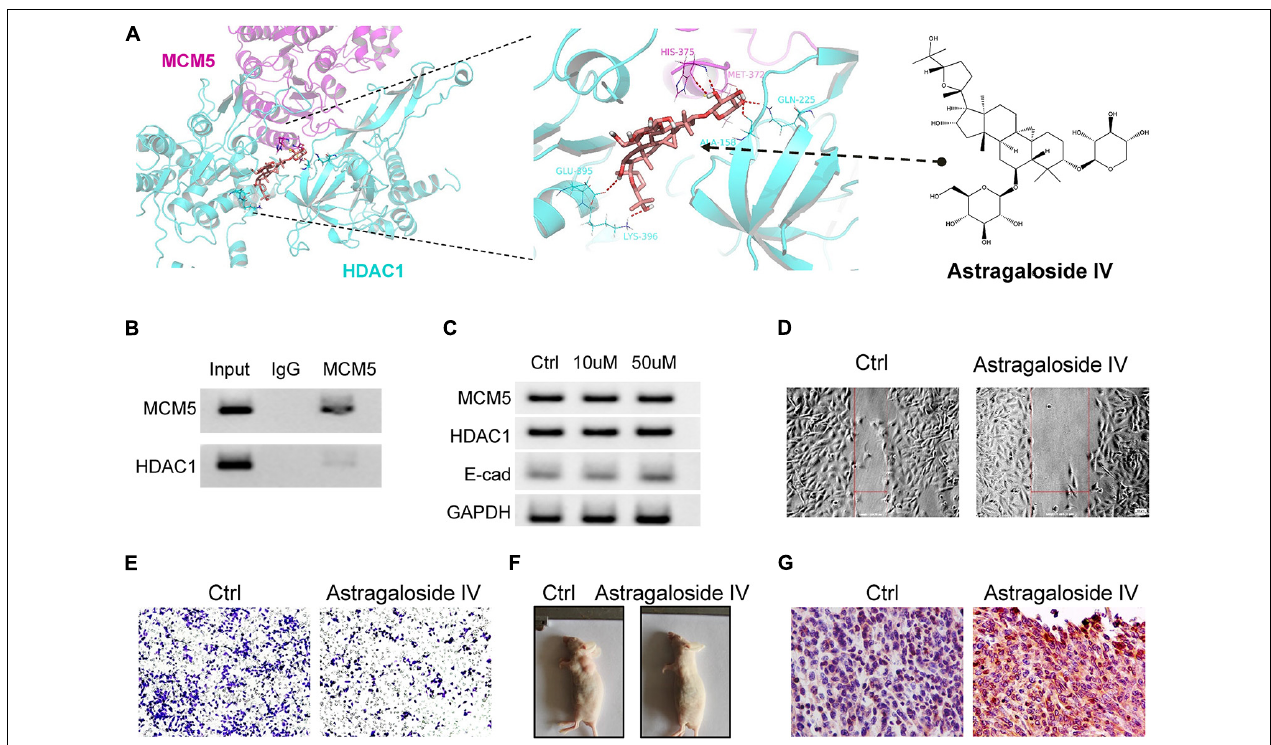
FIGURE 7 | Astragaloside IV inhibited lung cancer malignant progression. Tumor-bearing animals and SK-LU-1 cells were treated with astragaloside IV. (A) Molecular docking of MCM5/HDAC1 complex and astragaloside IV. (B) Co-immunoprecipitation was used to analyze the binding between MCM5 and HDAC1 after astragaloside IV treatment. (C) MCM5, HDAC1, and E-cadherin expression after astragaloside IV treatment. (D) Would-healing assay. (E) Invasive-ability analysis. (F) Images of subcutaneous tumors. (G) Detection of E-cadherin in tumors by immunohistochemistry. * P <